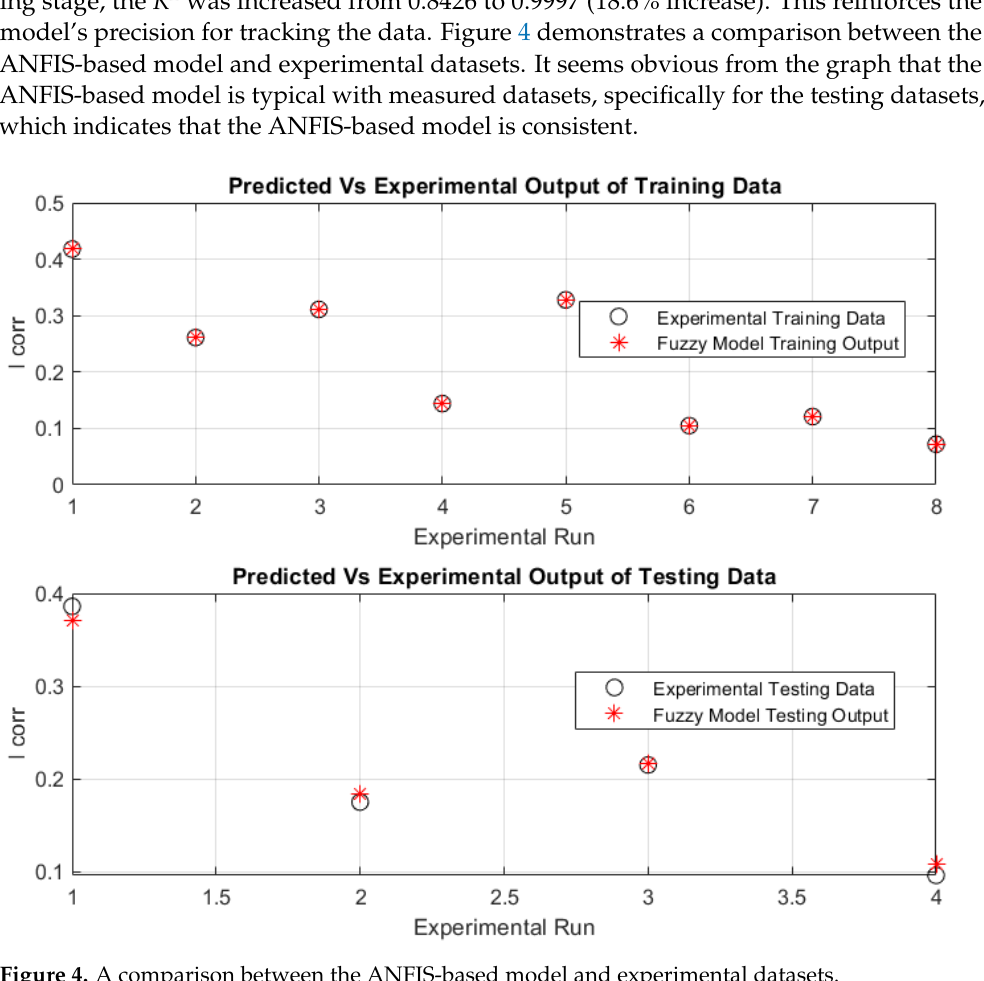
Figure 4. A comparison between the ANFIS-based model and experimental datasets.